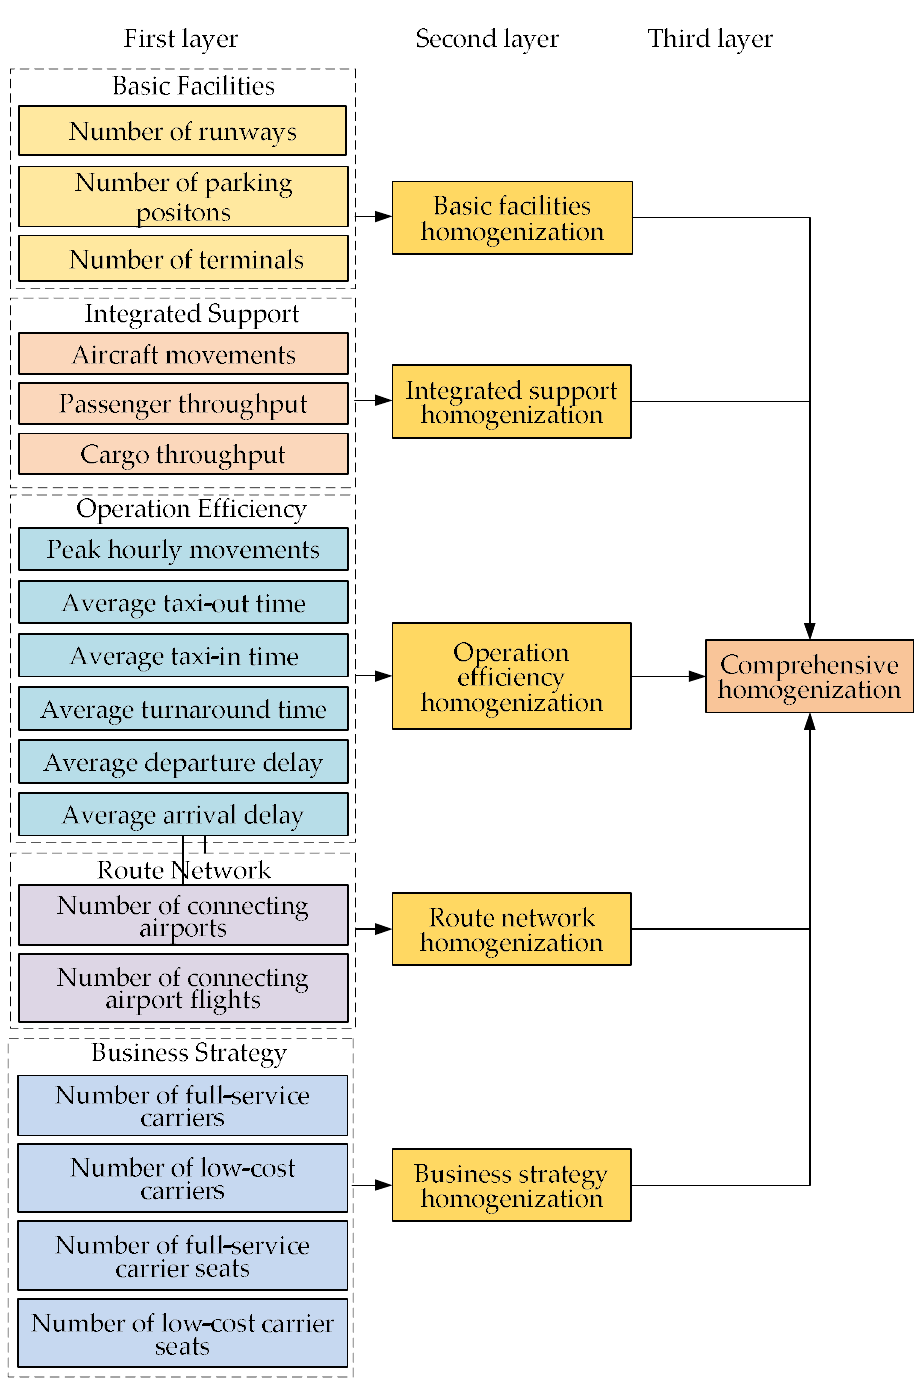
Figure 1. Framework of homogenization assessment based on multi-dimensional indicator system.